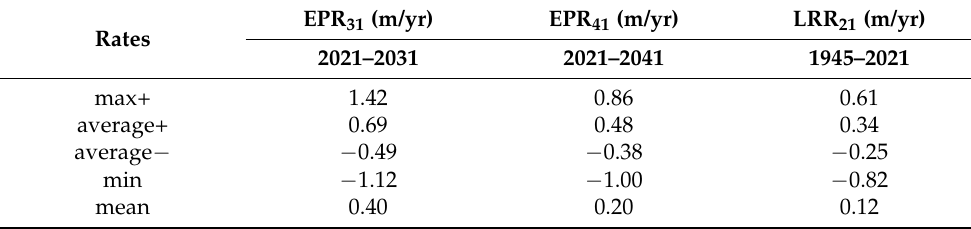
Table 5. Comparison of the forecasted EPR rates and LRR 21 .